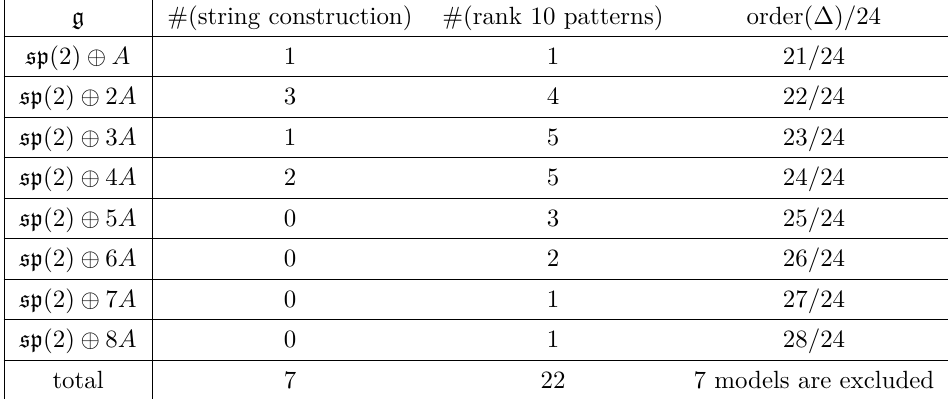
Table 6 . As an illustration of the power of 3 -brane bound, we show a subset of the gauge algebras sp (2) ⊕ nA , where the total rank is 10 and no u (1) factor. The second column is the number of patterns realized by F-theory on elliptic K 3 with one frozen singularity. The third column is the number of patterns consistent with the probe 1 -brane bound [6]. The last column shows the patterns excluded by the probe 3 -brane bound (3.15), order (∆) / 24 ≤ 1 . g c g singularity #( 7 -brane) ADE No. in [21]